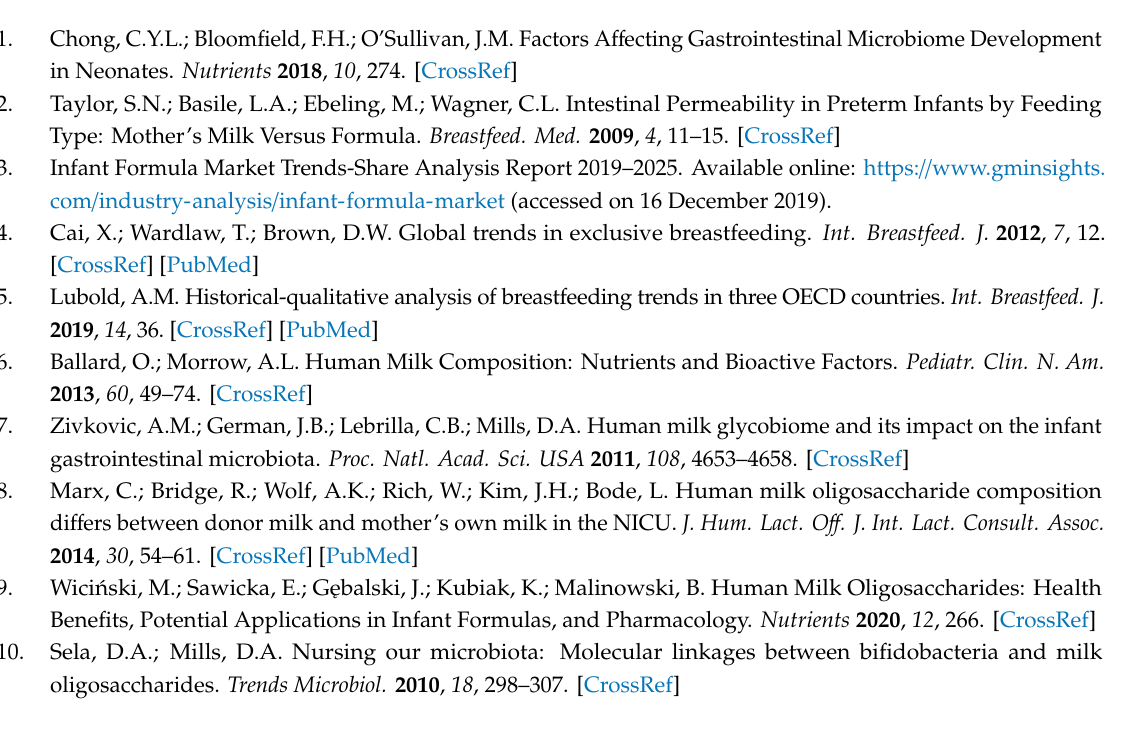
Table S1. Experimental diet composition from weeks 3–9 and 10–11; Table S2. Gut microbial group specific primers for qPCR; Table S3. Primer sequences for RT-PCR; Table S4. Male and female body composition; Table S5. Male and female serum inflammatory cytokines at 11 weeks of age; Table S6. Correlation analysis in males for a panel of inflammatory cytokines and mRNA levels that maintain intestinal barrier function; Table S7. Correlation analysis in females for a panel of inflammatory cytokines and mRNA levels that maintain intestinal barrier function; Table S8. Relative abundance of fecal microbiota (qPCR) in male rats at 11 weeks; Table S9. Relative abundance of fecal microbiota (qPCR) in female rats at 11 weeks of age; Figure S1. Serum fasting leptin levels; Figure S2. Correlation analysis between fat mass and leptin; Figure S3. Cecum and colon weight; Figure S4. Male and female alpha diversity using the Simpson index; Figure S5. Male and female beta diversity at 11 weeks of age; Figure S6. Heatmap of top gut bacterial phyla, families, and genera between treatments in males at 11 weeks of age; Figure S7. Heatmap of top gut bacterial phyla, families, and genera between treatments in females at 11 weeks of